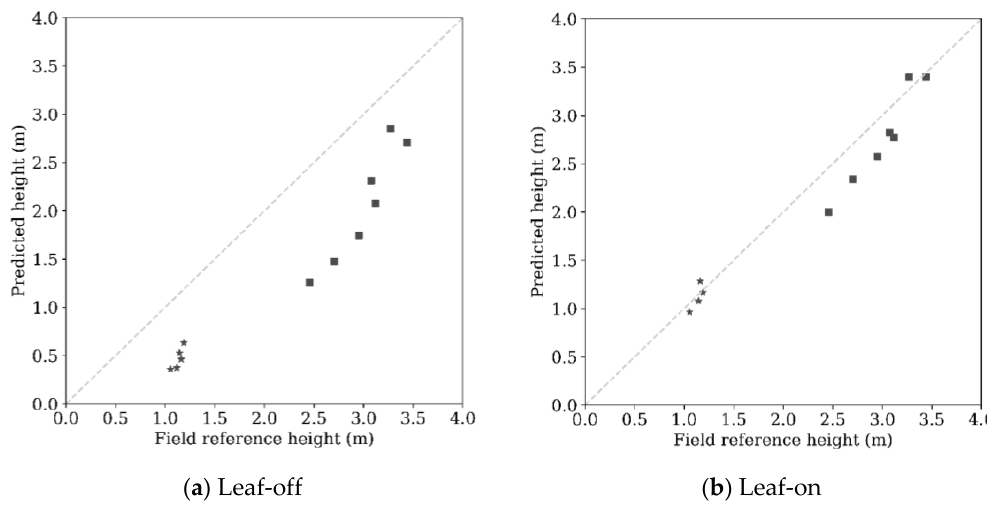
Figure 7. Height (unit: meter) of Norway spruce seedlings in leaf-off ( a ) and leaf-on ( b ) conditions, separating plots in young seedling stand (YoS, n = 5 ) and advanced seedling stand (AdS, n = 7 ) in canopy thresholds of 0.2 m. Table 8. Evaluation of the height estimation of Norway spruce trees among all ( n = 12 ), young seedling (YoS; n = 5 ), and advanced seedling (AdS; n = 7 ) plots in leaf-off and leaf-on conditions for each canopy threshold (C th ). Unit: meter.